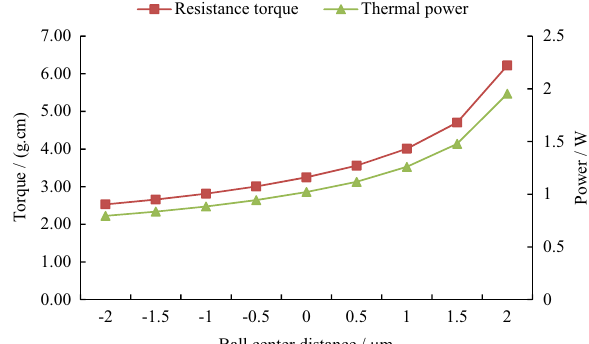
Figure 5. Friction torque and power at different ball center distances.